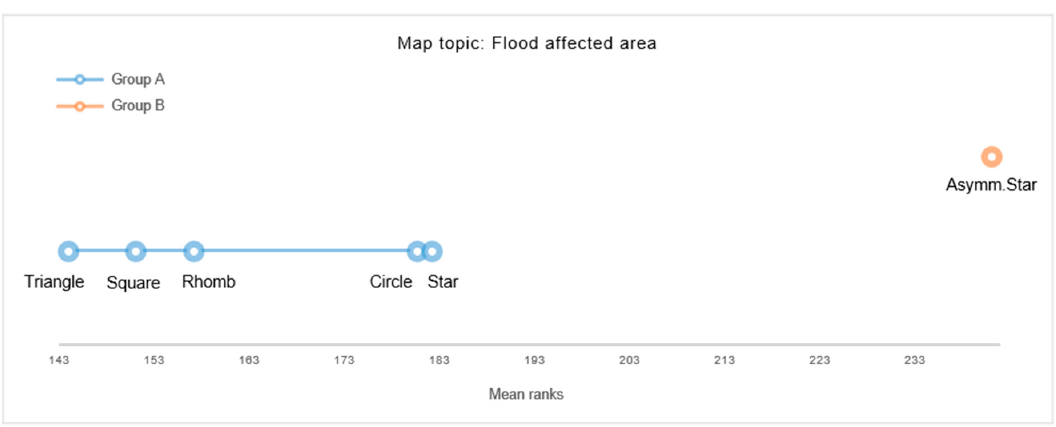
Figure 13. Map #9: Results of multiple pairwise comparisons, indicating groups of (dis)similar symbol-content congruence.